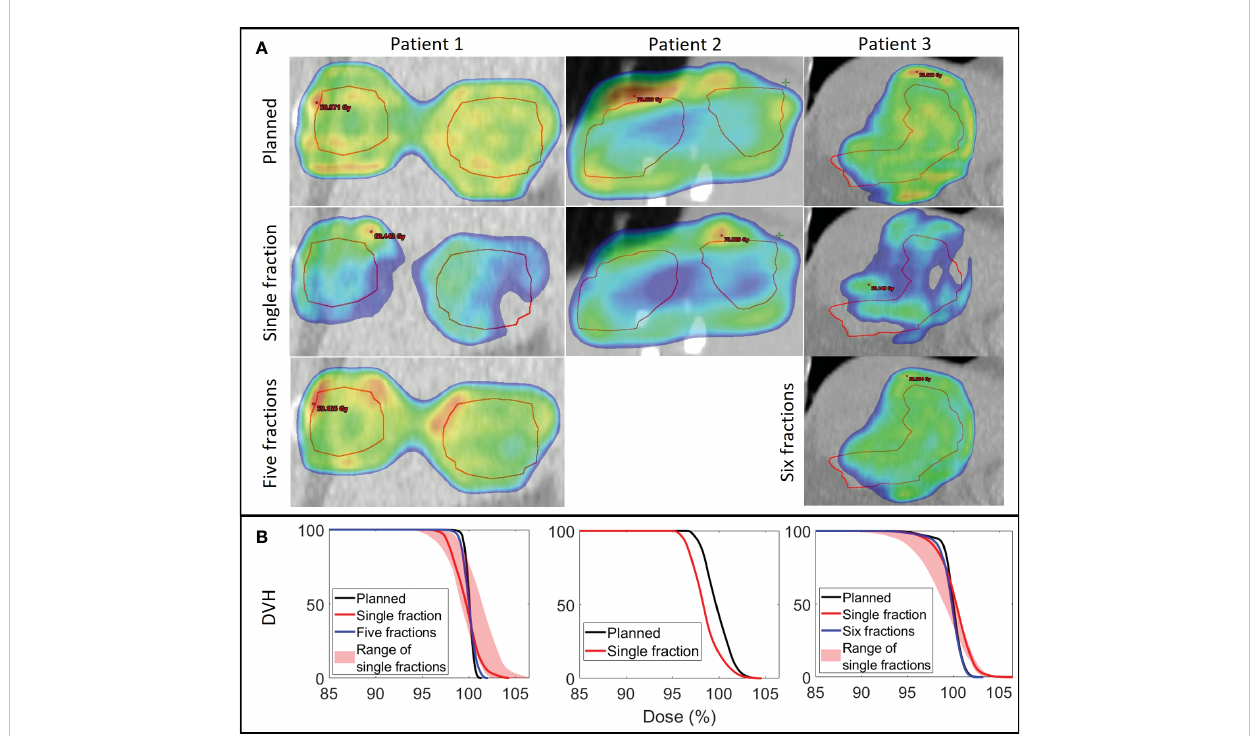
FIGURE 5 (A) Planned dose (1st row) and examples of reconstructed doses at a single fraction (2nd row) and averaged over all investigated fractions (3rd row) shown in a coronal plane through the center of the CTV (red contour) for each patient. Dose levels ≥ 95% are shown. Patient 2 only received one fraction. (B) Corresponding dose volume histograms (DVHs) for the CTV with the full range of single fraction DVHs indicated by the shaded